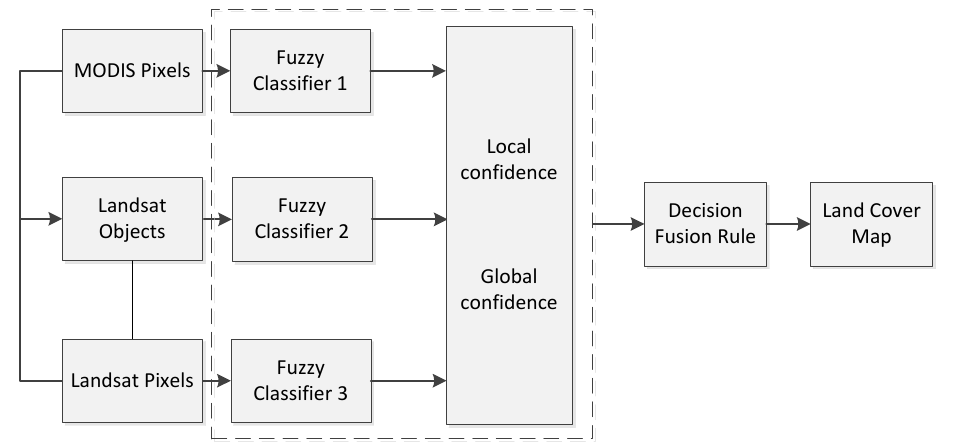
Figure 2. Overall Fusion Scheme of the method.